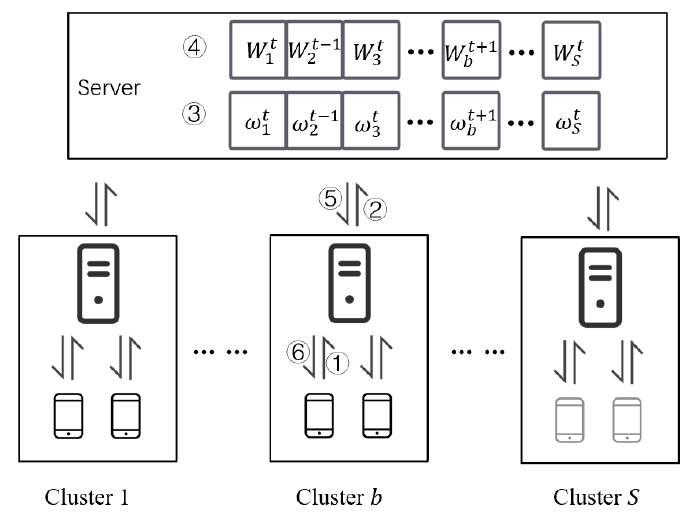
Figure 4. The process of FedTCM.